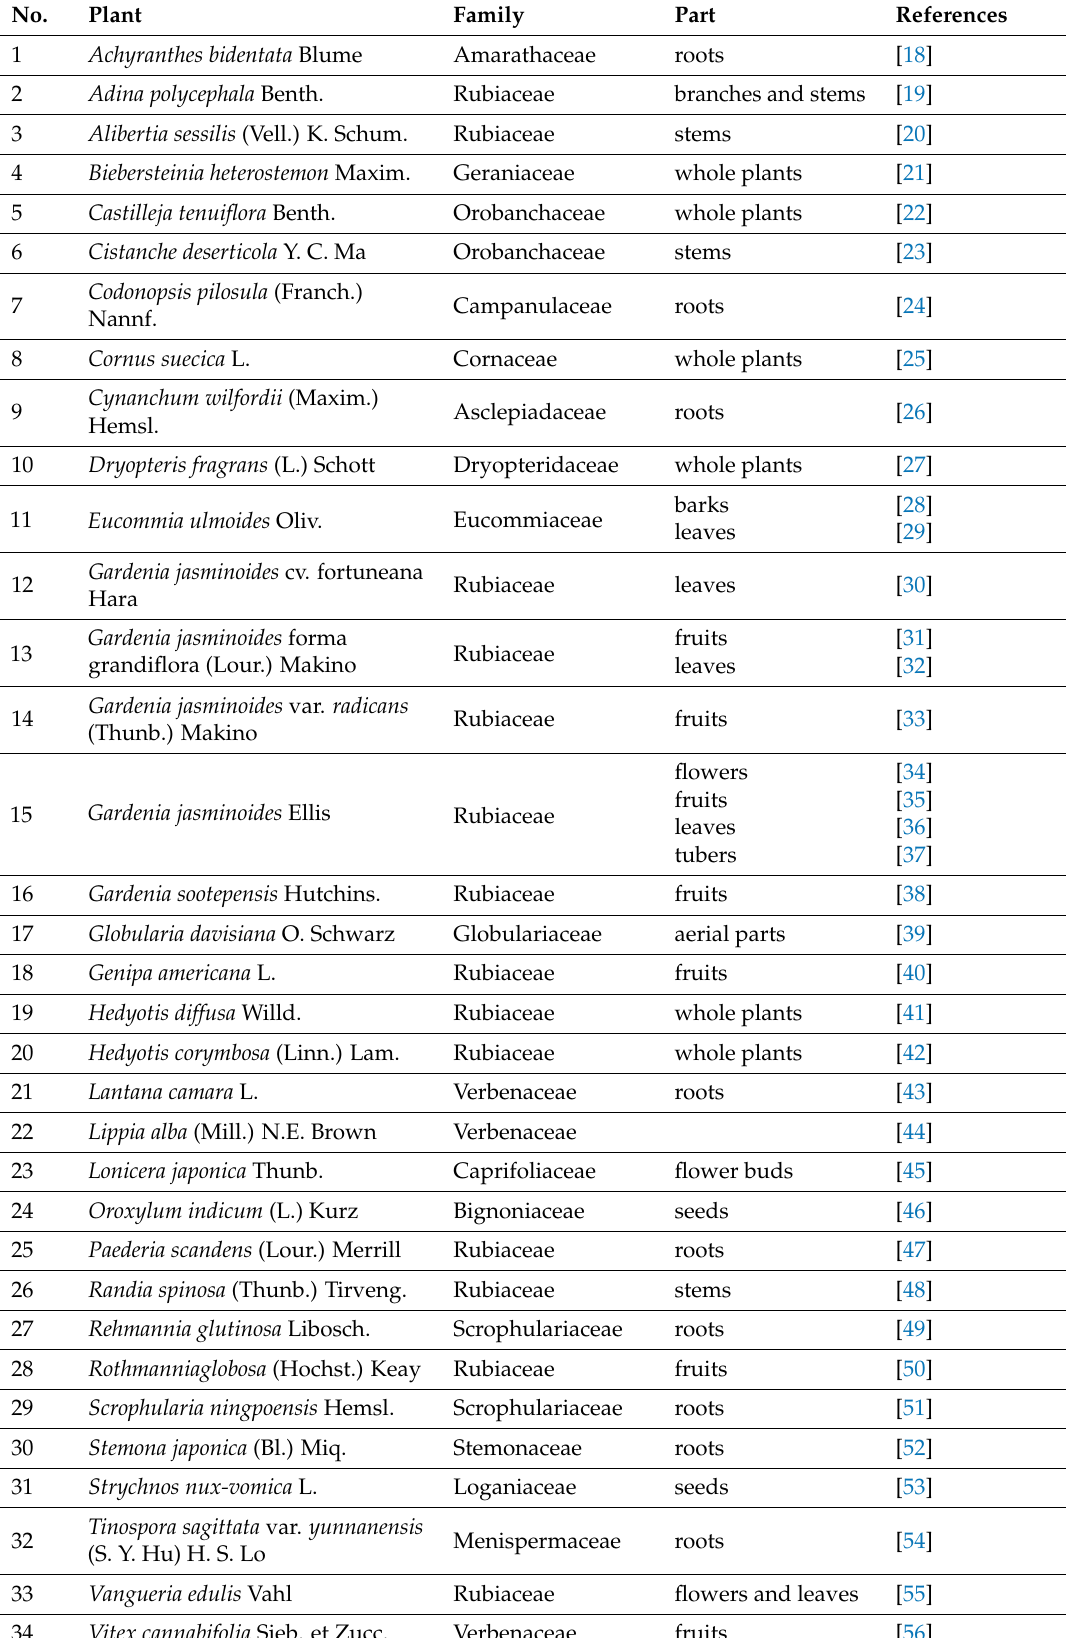
Table 1. Plants containing